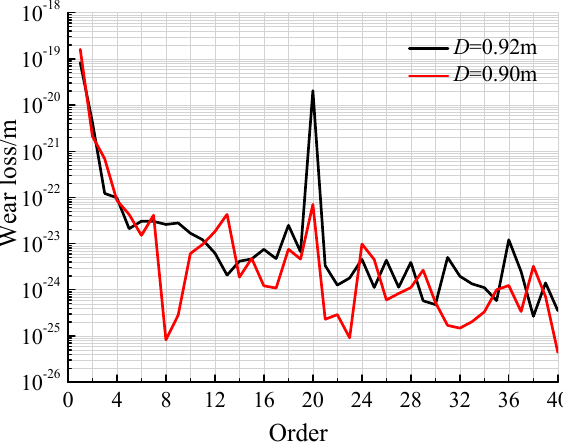
Figure 17. Calculated wear loss along the circumferences of wheels with two different diameters.